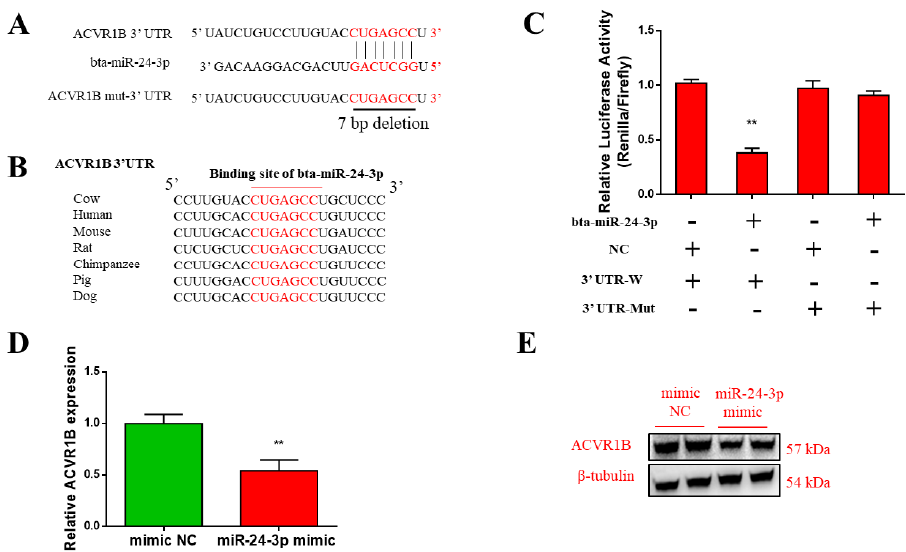
Figure 4. bta-miR-24-3p directly targets ACVR1B gene. ( A ) The predicted binding site of bta-miR-24-3p in ACVR1B 3’-UTR. The predict binding site (marked in red) was deleted in the mutated 3 ′ -UTR reporter. ( B ) Sequence alignment of the mature bta-miR-24-3p binding sites in seven different species. ( C ) HEK293T cells were co-transfected with bta-miR-24-3p mimics, as well as the dual-luciferase reporters linked to the wild-type or mutant bta-miR-24-3p binding sites. Relative luciferase activity was analyzed 48 h after transfection (** p < 0.01). ( D and E ) The transcript and protein levels of ACVR1B in HEK293T cells transfected with bta-miR-24-3p mimics 48 h after transfection. All data are represented as mean ± standard deviation (SD), based on at least three independent experiments for each treatment. * p < 0.05 and ** p <